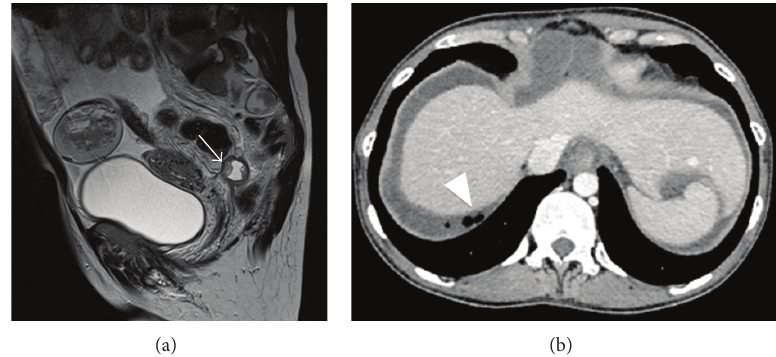
Figure 2: Sagittal T2 weighted image (a) and axial CT (b) demonstrate intraperitoneal rupture with fat globules in the cul de sac (arrow) and below the right hemidiaphragm (arrowhead), a pathognomonic finding.